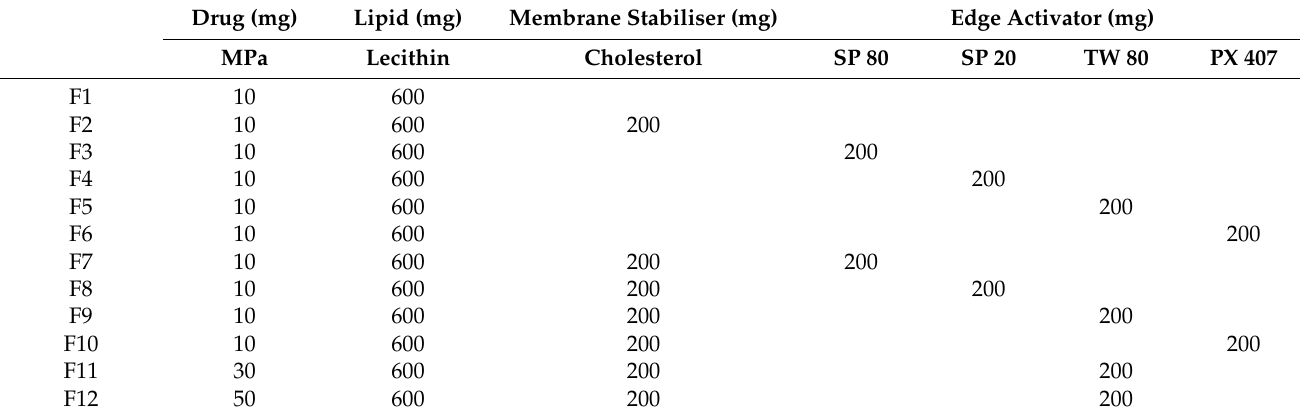
Table 1. Composition of MPa-loaded